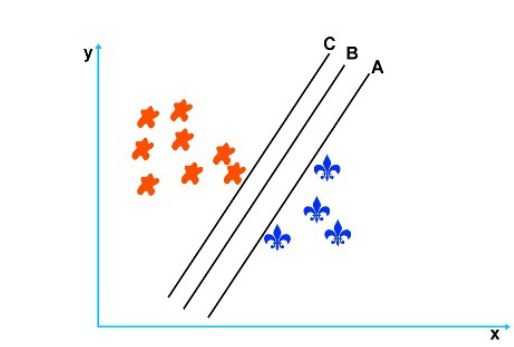
Identify the right hyperplane: Given three hyperplane 2.